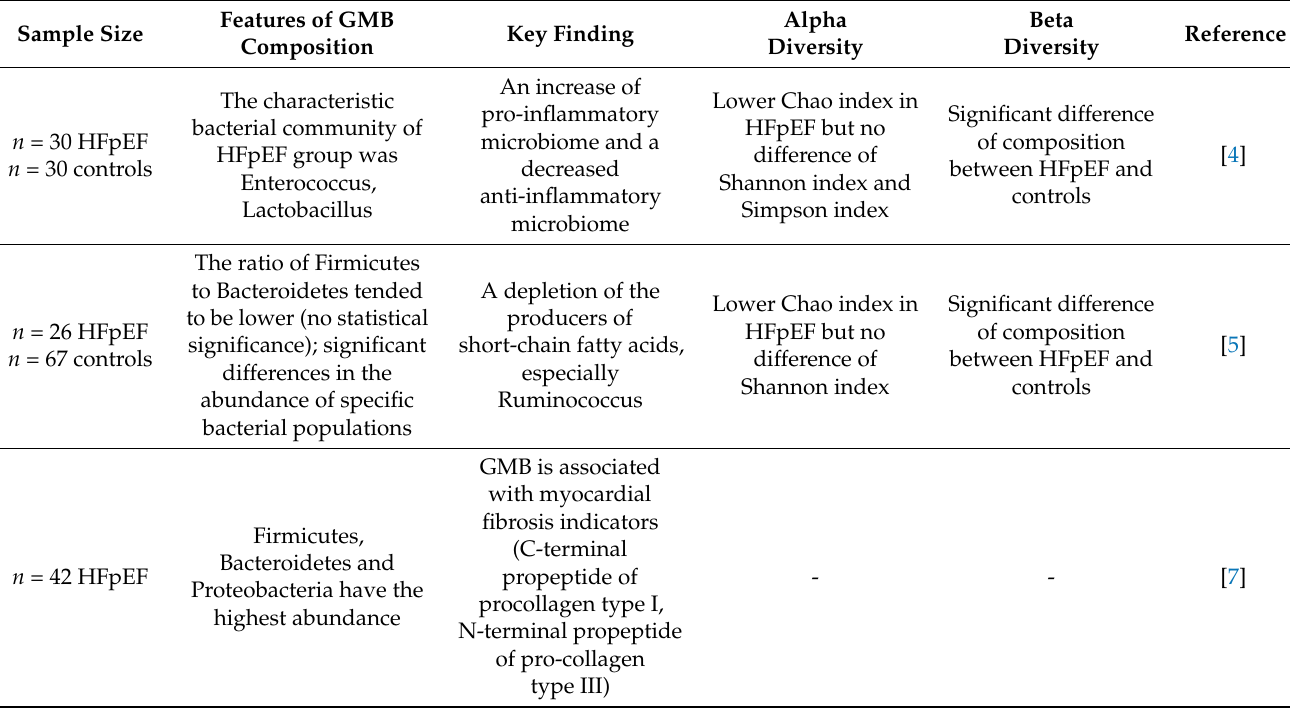
Table 1. Brief summary of studies investigating the features of gut microbiota (GMB) in heart failure with preserved ejection fraction